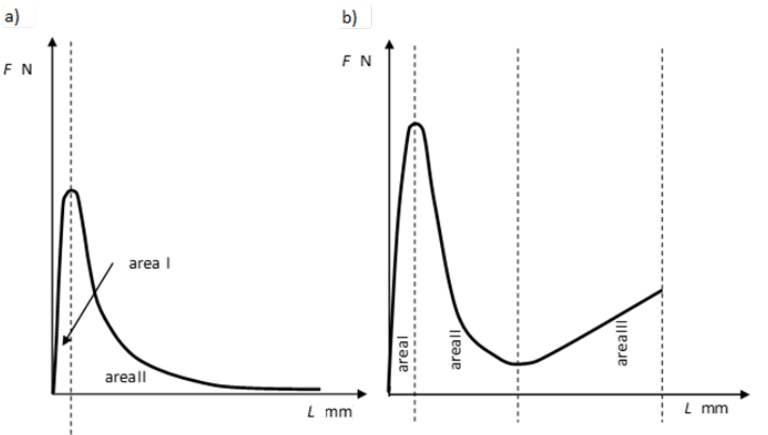
Figure 2. Example of relationship between the tensile force and elongation of a specimen of: ( a ) paving-grade (base) bitumen, ( b ) polymer-modified bitumen. Adapted from ref. [32].